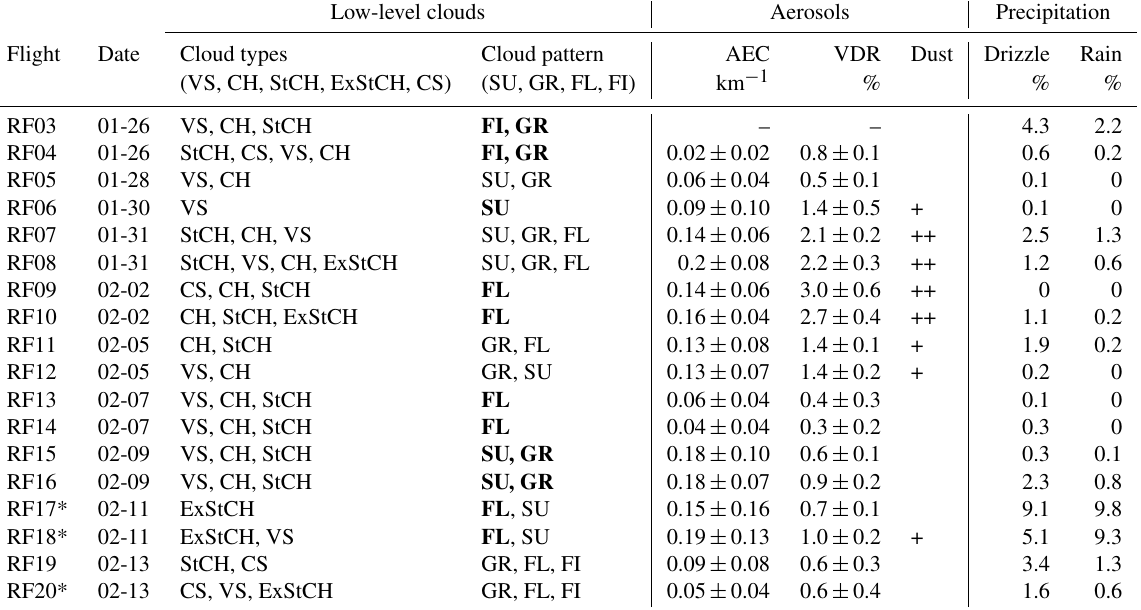
Table 4. Cloud, aerosol and precipitation conditions associated with ATR flights. Through the combined analysis of Fig. C2, GOES-E animations (Appendix B), BCO radar information and C 3 ONTEXT results (Schulz, 2022), the prominent low-level cloud types (at the scale of the R and L patterns) and cloud mesoscale patterns (at the scale of the EUREC 4 A circle) are reported for each ATR flight. The different low-level cloud types considered are very shallow cumuli (VS), vertically developed chimney clouds (CH), chimney clouds with stratiform outflow below the inversion (StCH) and chimney clouds with a horizontally extended stratiform layer (ExStCH). Clear-sky is referred to as CS. The mesoscale cloud patterns (referred to as SU, GR, FL or FI for Sugar, Gravel, Flowers and Fish) are defined in Stevens et al. (2020). They are written in bold when there is a consensus about their prominence during the flight. The aerosol extinction coefficient (AEC), volume depolarization ratio (VDR) and dust condition are from Chazette et al. (2020); dust+ corresponds to 1% ≤ VDR < 2% and dust++ to VDR ≥ 2%. The fractional areas (%) of the R patterns flown at cloud base covered by drizzle or rain are derived from the BASTA radar using reflectivity thresholds of − 20 and 0dBZ to distinguish clouds from drizzle and drizzle from rain, respectively (Sect. 3.5.3). Asterisks indicate the presence of deeper congestus clouds with cloud top at 5km (for RF17 and RF18) or alto-stratus layers between 5 and 8km for RF20.